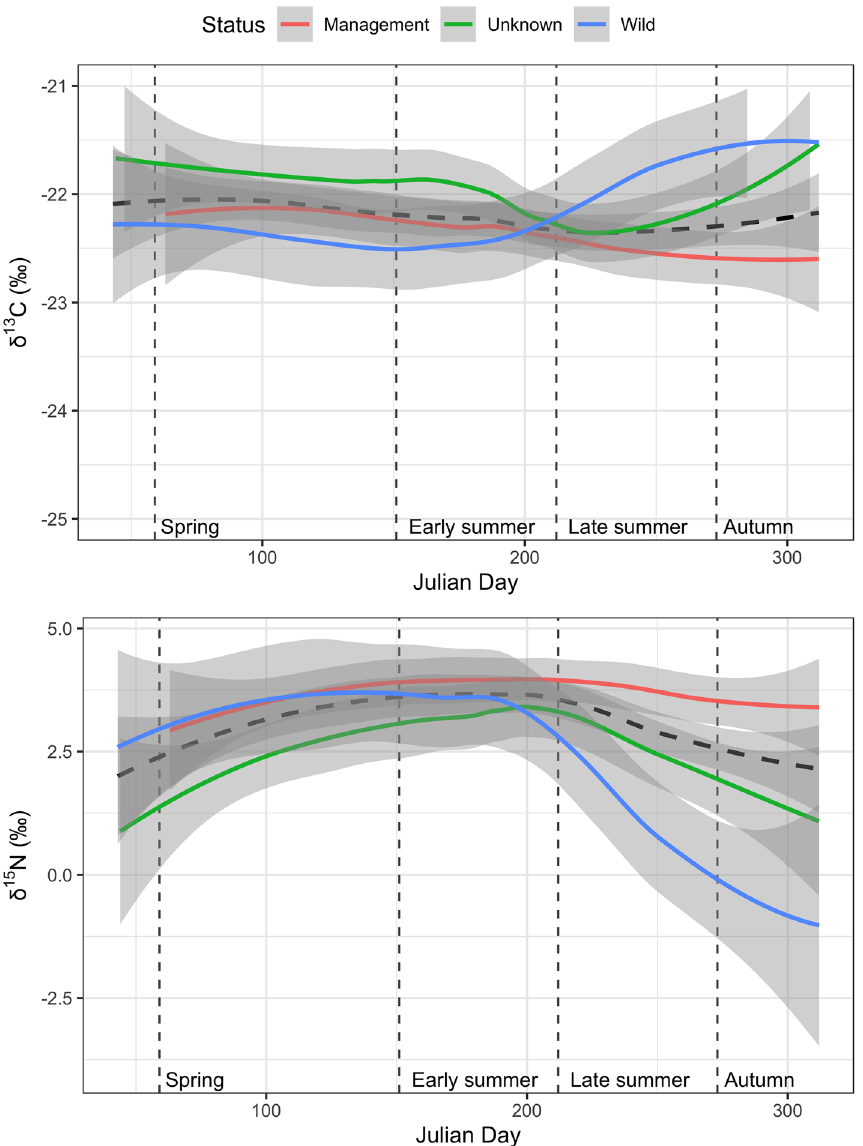
Figure 4. Stable isotope values (δ 13 C, upper panel, and δ 15 N, lower panel) of Apennine bear hair sections across the activity period (Abruzzo Lazio and Molise National Park, central Italy, June–September 2014). Dashed line indicates smoothed mean for the population and the grey shaded area its 95% confidence